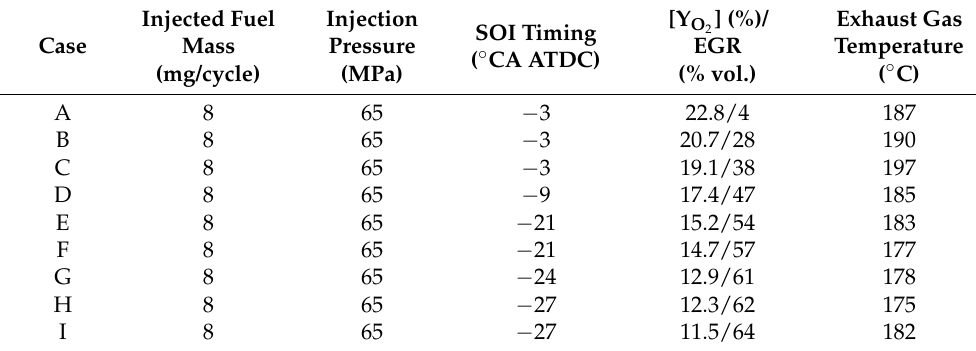
Table 2. Test points (Constant engine speed, 1500 rev.min − 1 , Single injection, 100 kPa, absolute, intake